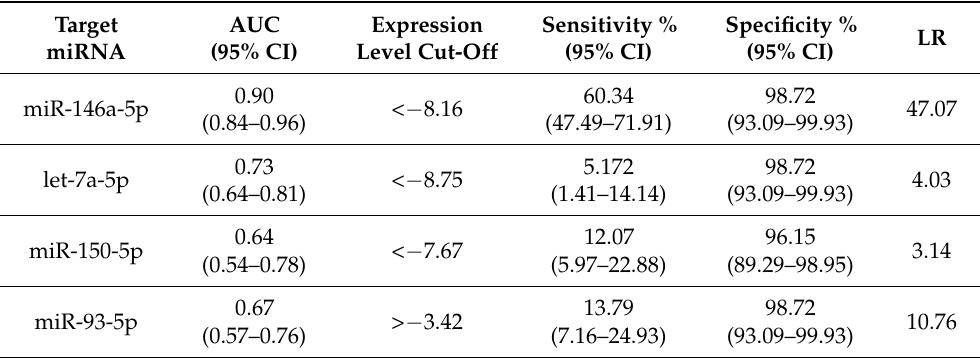
Table 3. Diagnostic performance in differentiating chronic schistosomiasis patients with and without hepatic fibrosis of the designated expression cut-off value at baseline for each circulating serum miRNA based on ROC analysis.